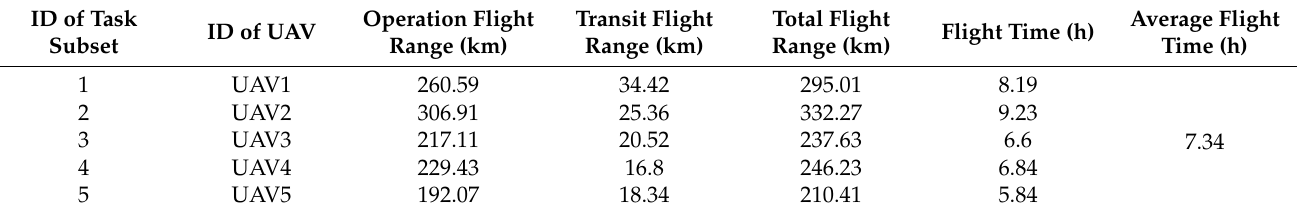
Table 4. Results obtained via the manual scheduling method.